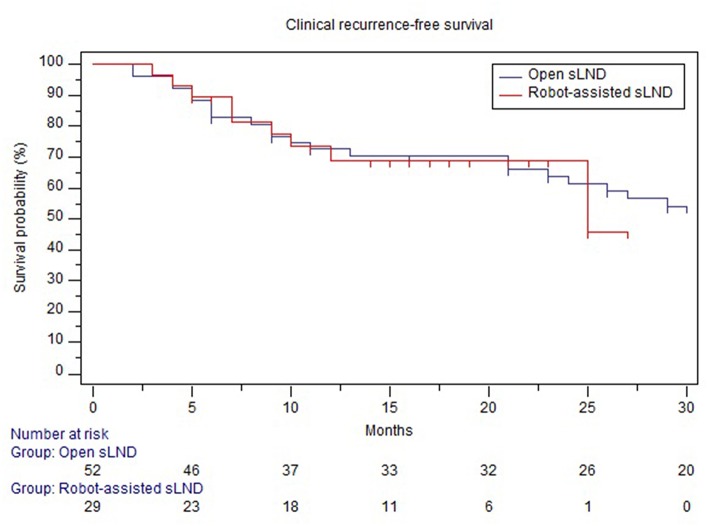
Comparison of clinical recurrence-free survival between open and robotic sLND. Censored patients are marked with small vertical lines.